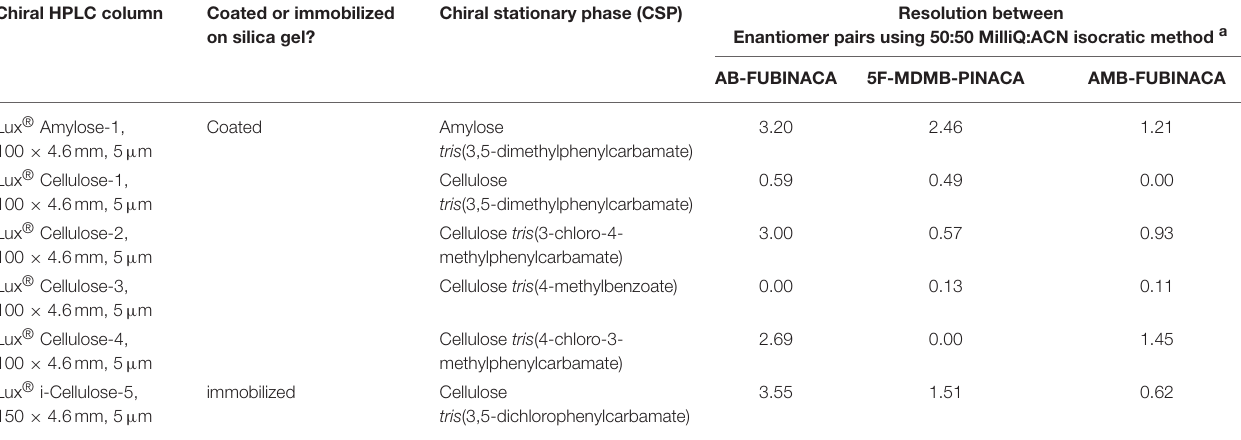
TABLE 2 | Preliminary Screening of Phenomenex Lux ® Chiral HPLC columns for indazole-3-carboxamide synthetic cannabinoid enantiomer separation. Chiral HPLC